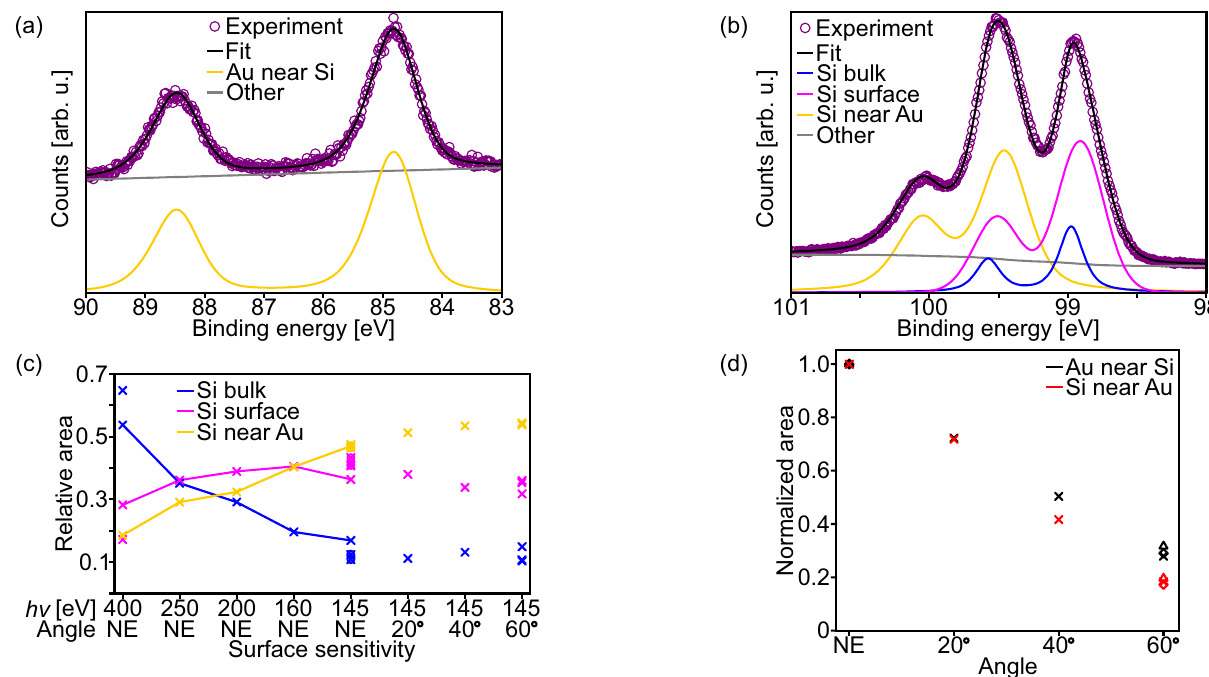
Figure 6. ( a , b ) Fitting results of as measured ( a ) Au 4f and ( b ) Si 2p spectra of an Au silicide nanowires sample 145 eV photons at NE. ( c ) Diagram illustrating the relative intensities of the Si 2p spectral taken with h ν = components with respect to the total intensity of the line depending on the surface sensitivity for multiple samples. The lines connect the points obtained by fitting the spectra from Fig. 5b. The circles indicate fits with an asymmetric Au silicide component. If there appear to be fewer data points for a component than for the others at a given surface sensitivity, there are overlapping data points. ( d ) Diagram depicting the area of the Au silicide Si 2p spectral component and Au silicide Au 4f line depending on the emission angle and normalized to the area of NE for multiple samples indicated by different